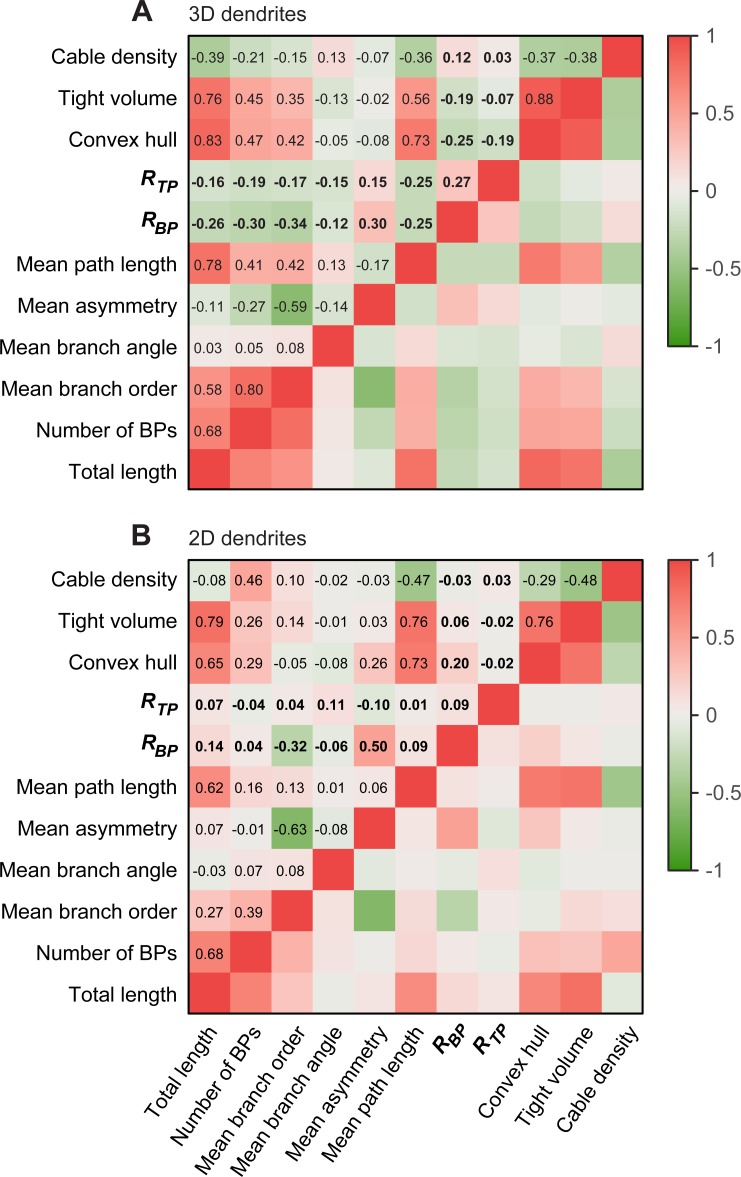
Correlation matrix between R values and other branching statistics.A. Correlation matrix of RBP and RTP with other typical branching statistics (bold) in the lumped 3D cells from Fig 2A. B. Similar correlation matrix but using the 2D cells of Fig 2B.